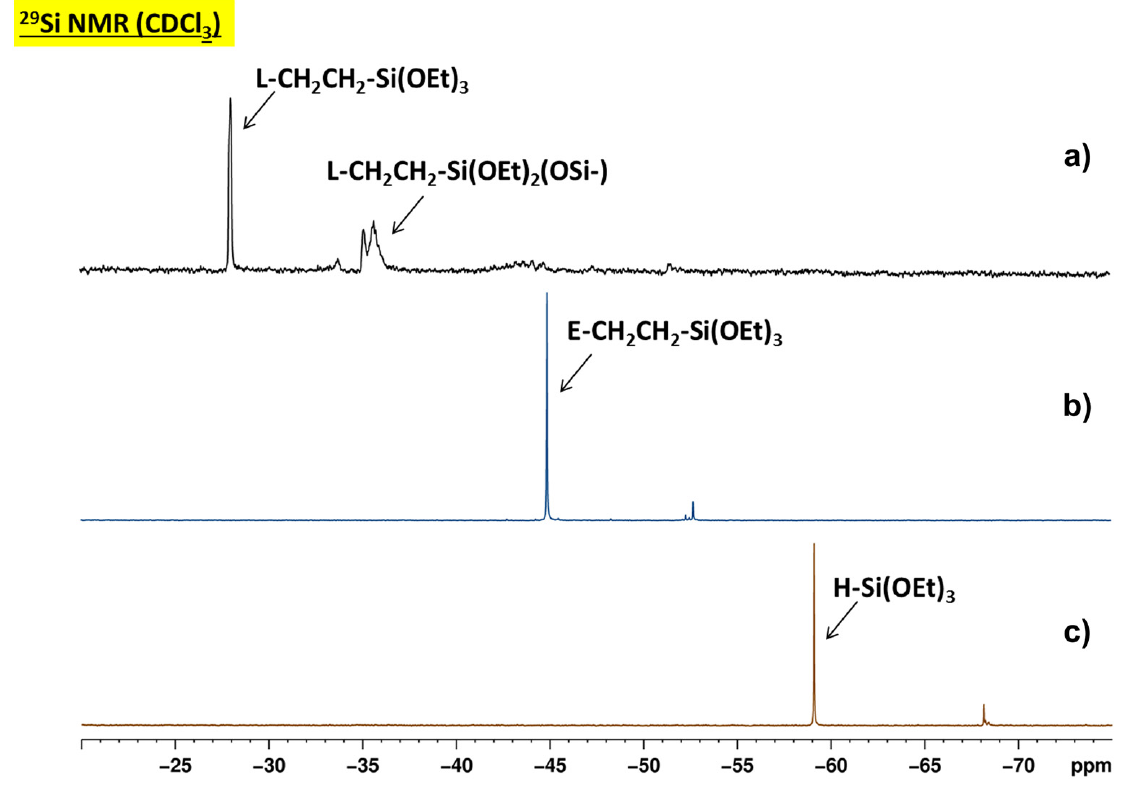
Figure 2. 29 Si NMR spectra of the products obtained by hydrosilylation of linalool ( a ) and eugenol ( b ) with HSi(OEt) 3 ( c ).